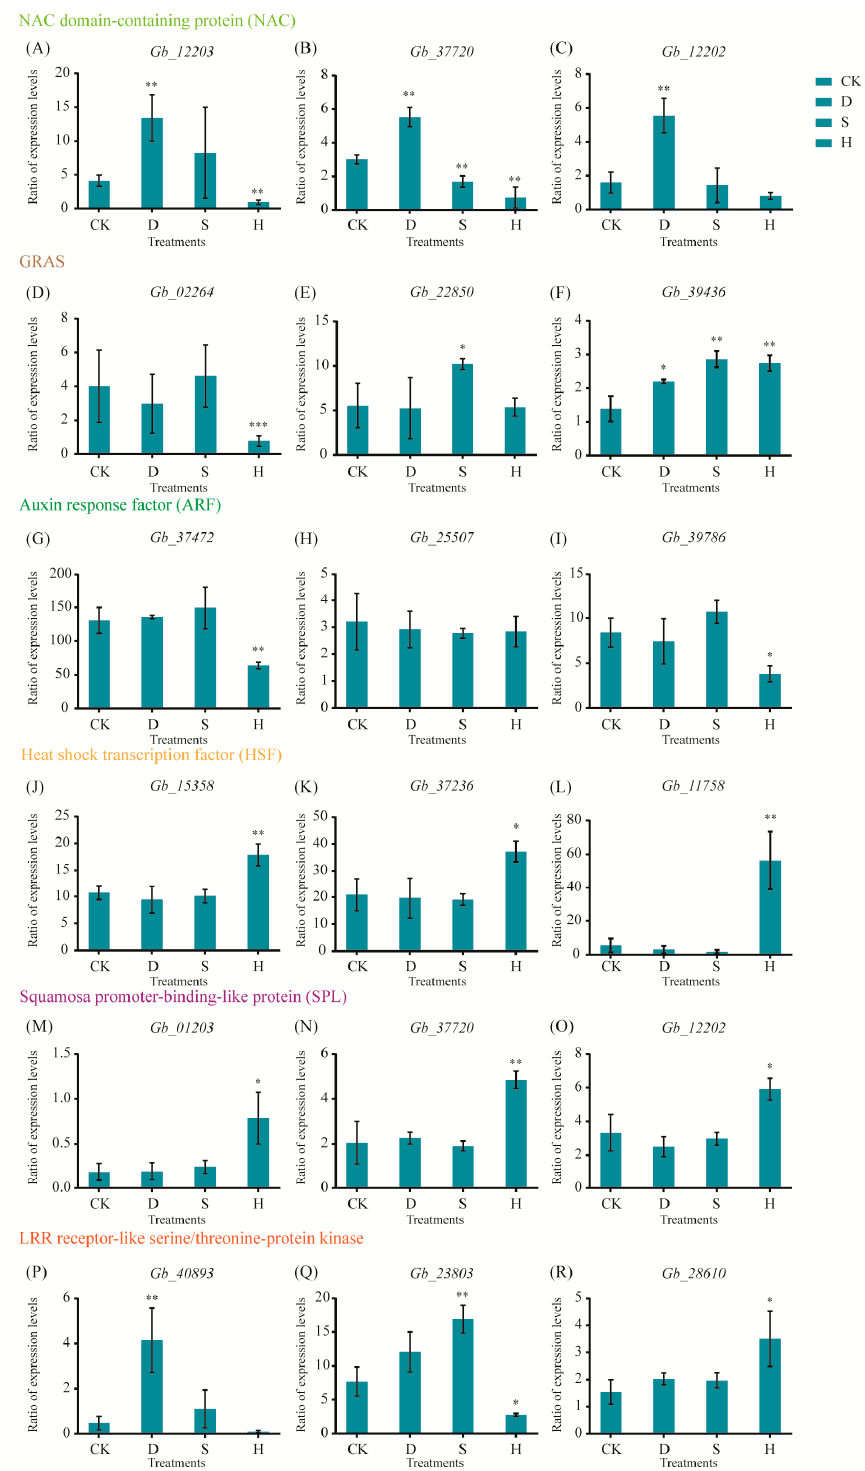
Figure 6. Expression of key genes under drought, salt, and heat stresses based on qRT-PCR. ( A–C ) NAC genes: ( A ) Gb_12203 , ( B ) Gb_37720 , and ( C ) Gb_12202. ( D–F ) GRAS genes: ( D ) Gb_02264 , ( E ) Gb_22850 , and ( F ) Gb_39436. ( G–I ) ARF genes: ( G ) Gb_37472 , ( H ) Gb_25507 , and ( I ) Gb_39786. ( J–L ) HSF genes: ( J ) Gb_15358 , ( K ) Gb_37236 , and ( L ) Gb_11758. ( M–O ) SPL genes: ( M ) Gb_01203 , ( N ) Gb_37720 , and ( O ) Gb_12202. ( P–R ) LRR receptor-like serine/threonine-protein kinase genes: ( P ) Gb_40893 , ( Q ) Gb_23803 , and ( R ) Gb_28610. Error bars represent the mean ± SD; n = 3; */**, p < 0.05/0.01, respectively, compared with CK. CK: Control; D: Drought; S: Salt; H: Heat.